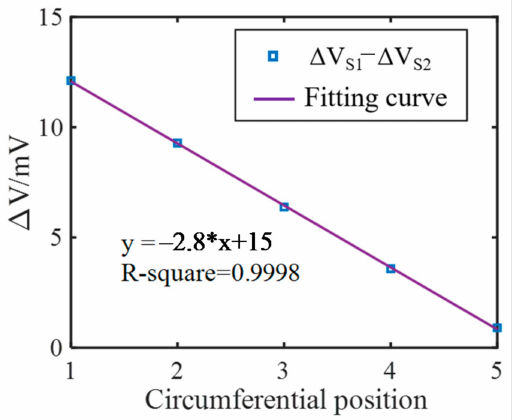
Figure 11. The difference voltage of the S1 and S2 versus the crack circumferential position.